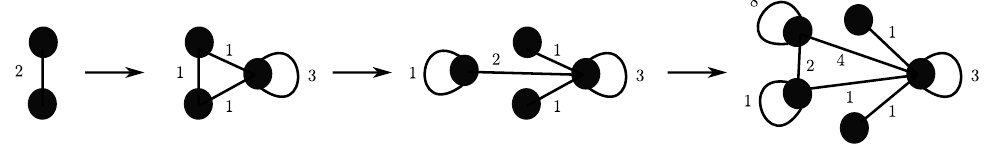
Figure 11. Chain of dualities obtained by unlinking. Numbers next to edges denote